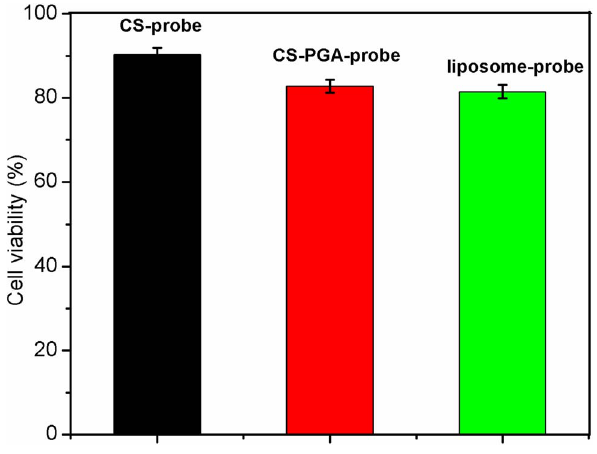
Figure 7. Cytotoxicity induced by QD-RNA-Au NP probe loaded CS, CS/ c -PGA complex and liposome in MCF-7 cells.